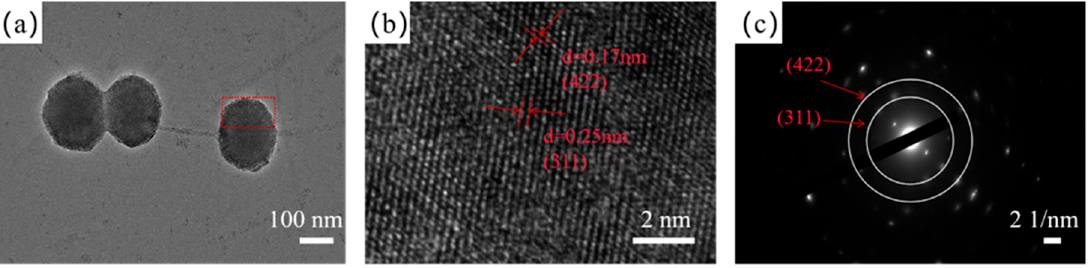
Figure 4. ( a ) TEM image of CoFe 2 O 4 /SWCNTs, ( b ) HRTEM image of CoFe 2 O 4 /SWCNTs and ( c ) selected area electron diffraction (SAED) image of CoFe 2 O 4 /SWCNTs.